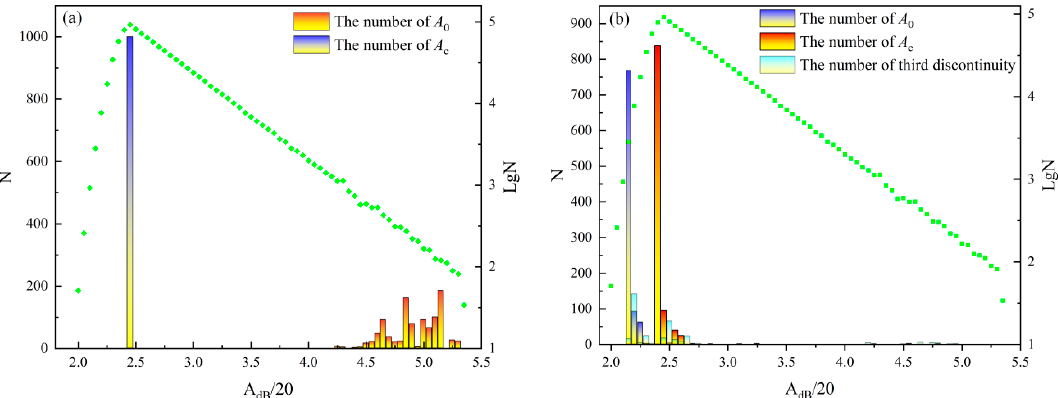
Figure 5. Search for A c and A 0 of apparent amplitude-frequency distribution by FGS and MBASS. In order for MBASS to estimate 1000 Bootstrap samples, we generated 100,000 data volumes. ( a ) FGS. ( b ) MBASS; we also counted the number of third discontinuities of 1000 Bootstrap samples.